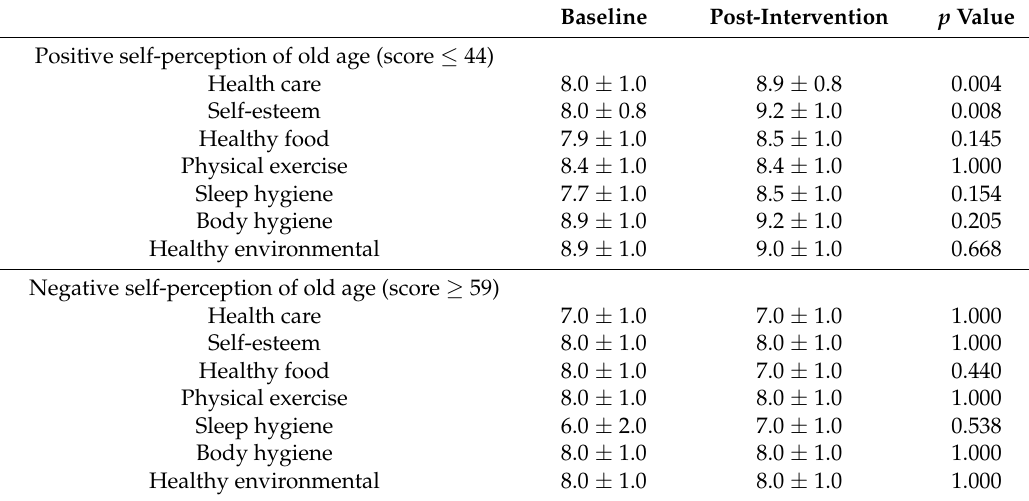
Table 7. Self-efficacy of self-care actions related to positive and negative self-perception of old